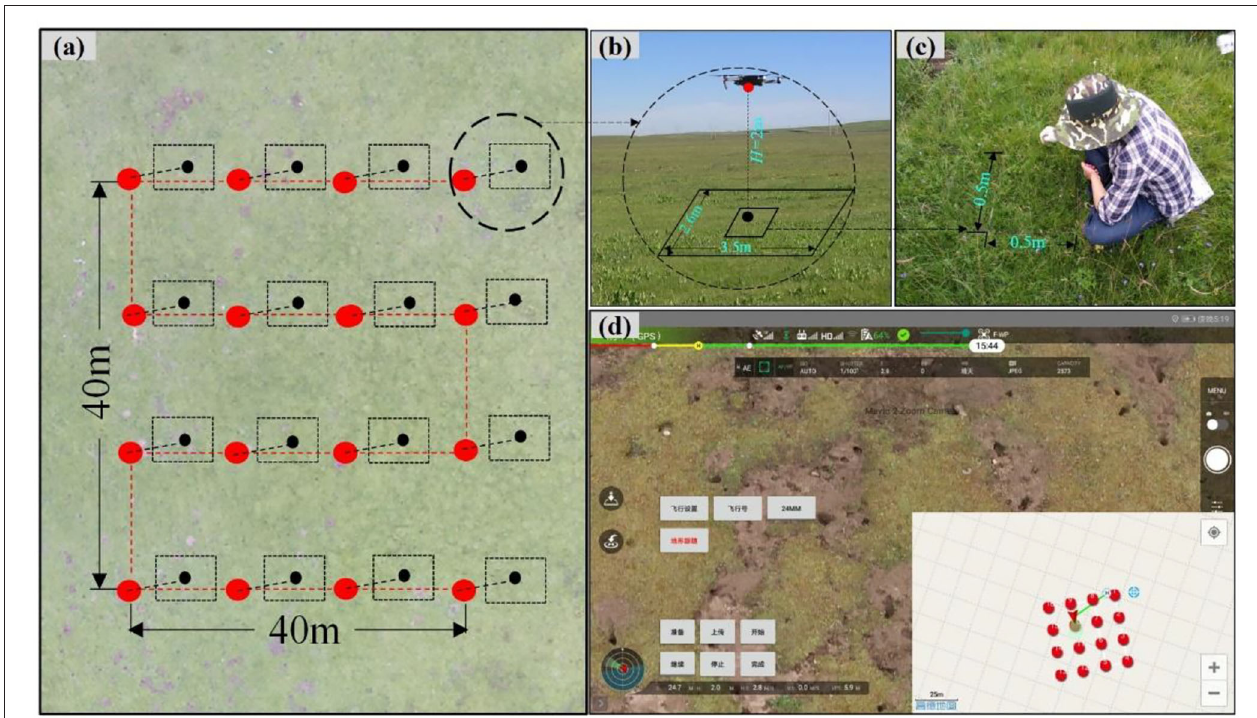
FIGURE 2 | Field sampling method: (a) waypoints (large red dots), flight trajectory (red dashed line), and area of aerial photograph (black frame with the center represented by black dots); (b) aerial photograph taken by MAVIC Pro at the height of 2m; (c) traditional ground-based measurement (3 quadrats selected randomly among 16 sampling sites); and (d) real-time sampling along the “Belt” trajectory of FragMAP